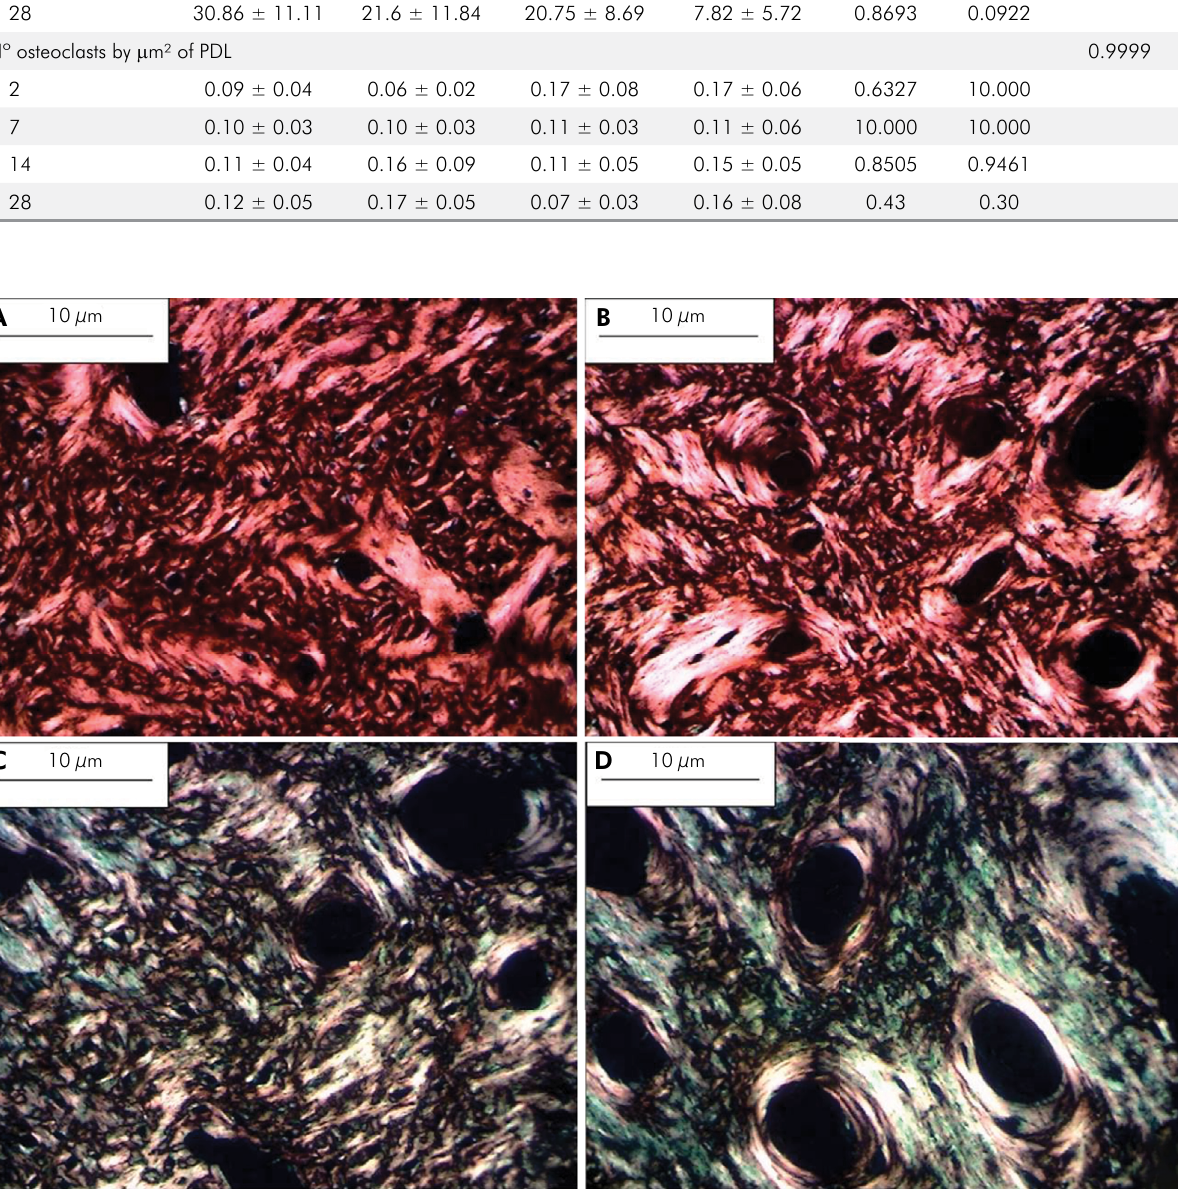
Figure 2. Photomicrographs of the S, F, SM, and FM groups on the 2 nd day of orthodontic tooth movement. In groups S (A) and F (B), there is a predominance of type I collagen (mature); in groups SM (C) and FM (D), replacement of collagen type I (mature) for collagen III (immature) is observed (Picrosirius,